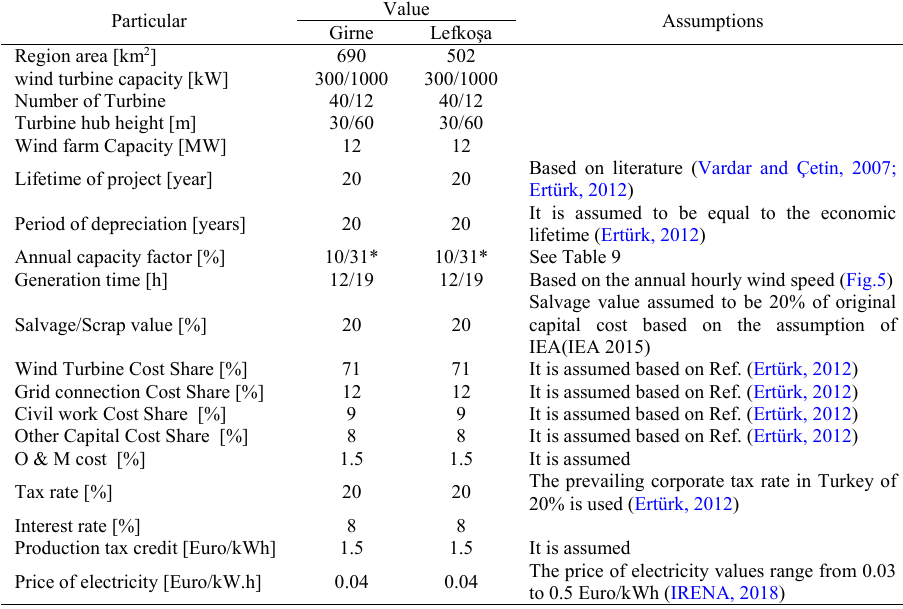
Table 7: Values and assumptions for the economics of wind energy Particular